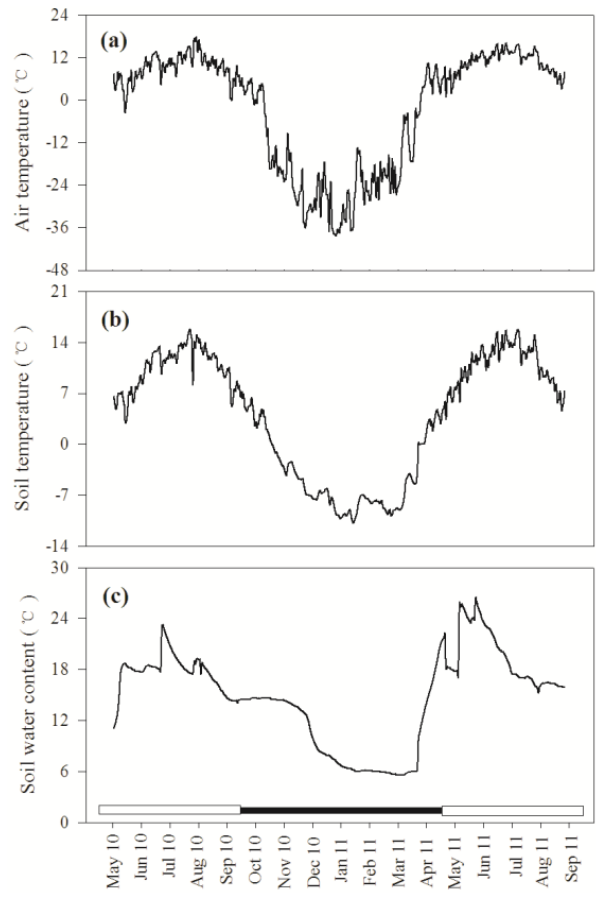
Fig. 1. Air temperature (a) , soil temperature at 10cm depth (b) and Fig. 1 Air temperature (a), soil temperature at 10 cm depth (b) and soil water content 4 soil water content at 10cm depth (c) from May 2010 to September 2011 in an alpine grassland in the Tianshan mountains. White and at 10 cm depth (c) from May 2010 to September 2011 in an alpine grassland in the 5 black horizontal bars represent within (2010 and 2011) and outside the growing season, respectively. Tianshan mountains.White and black horizontal bars represent within (2010 and 2011) 6